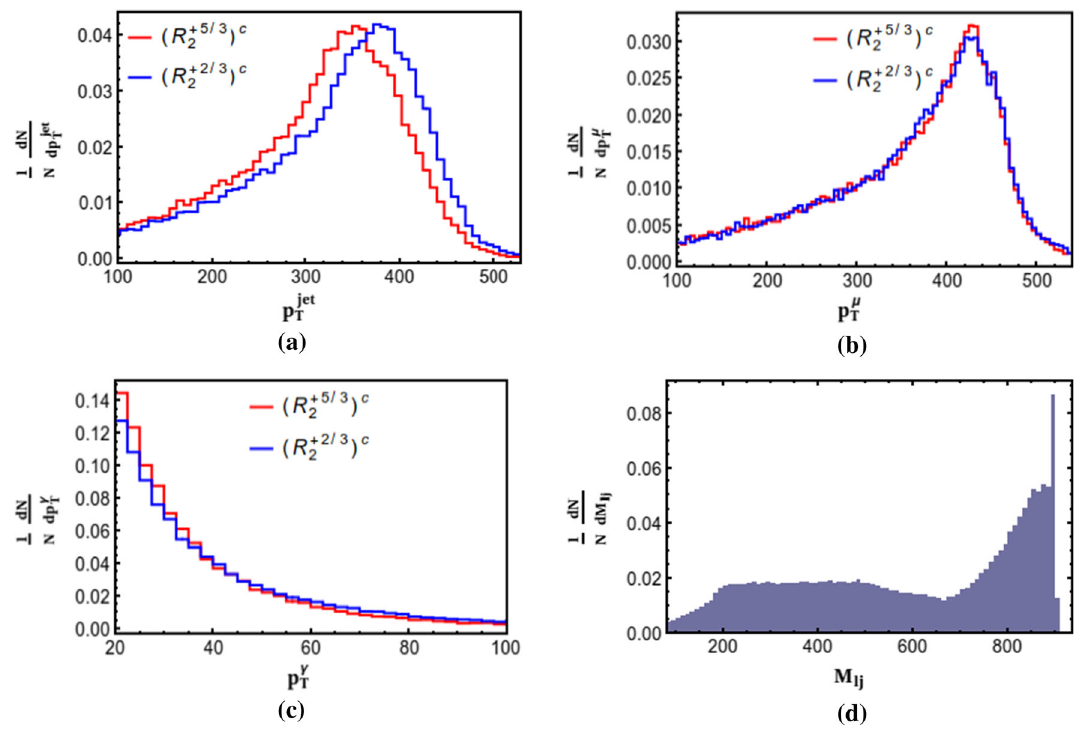
√ s = 1183 . 2 GeV for the scalar-doublet leptoquark R c